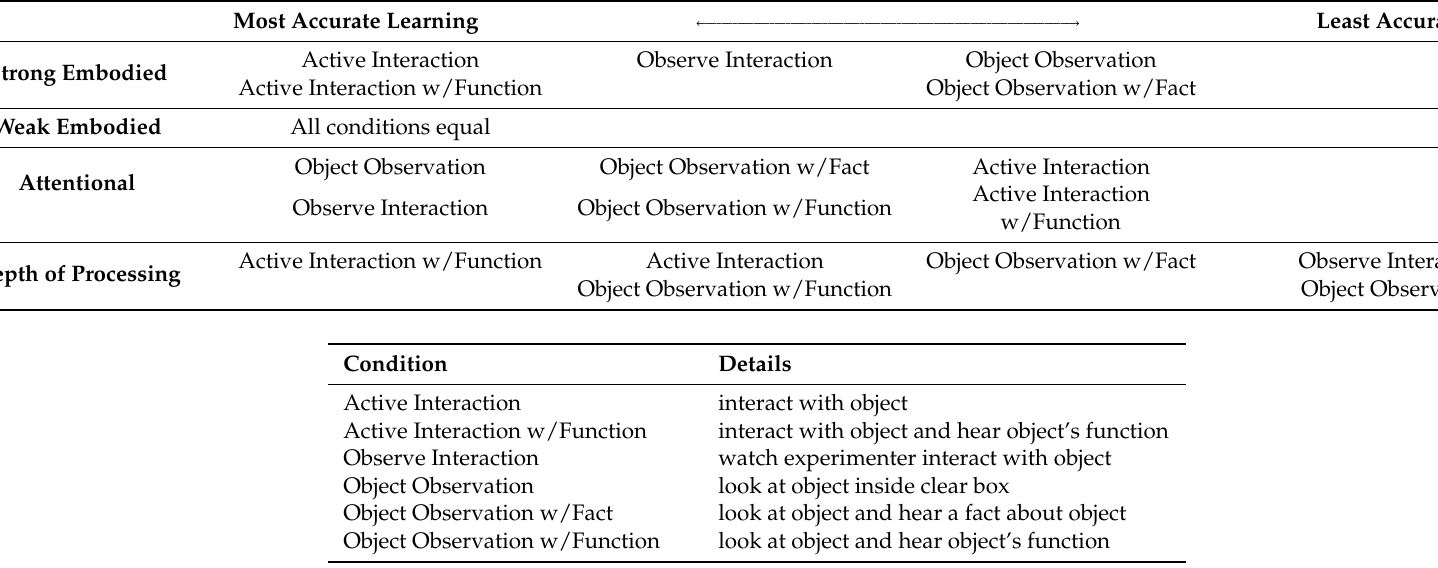
Table A1. Predictions for Experiment 1, derived from four theoretical perspectives.